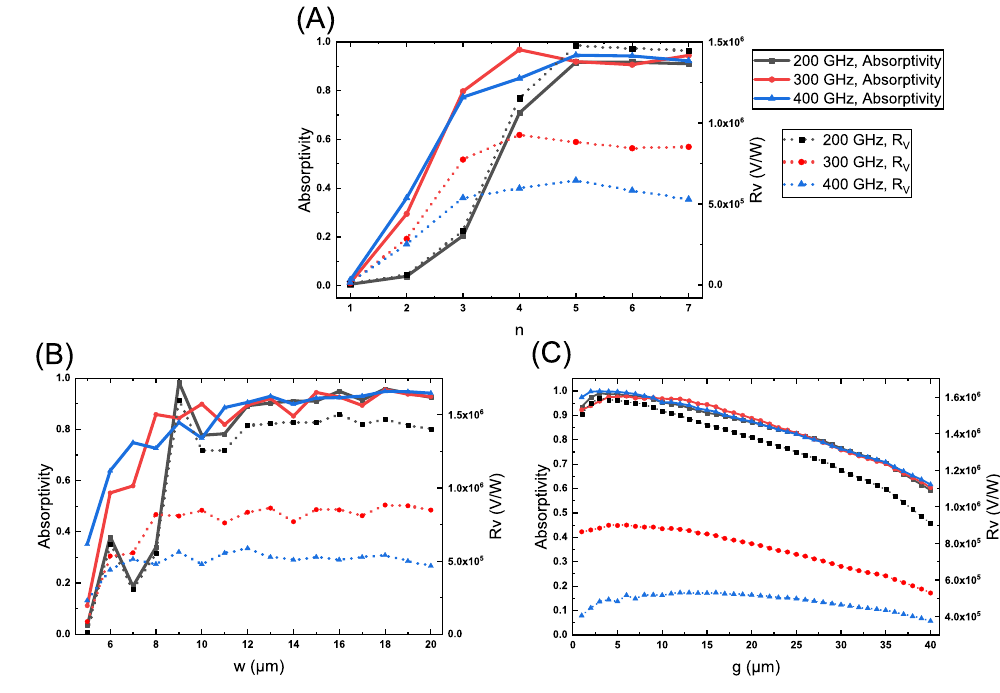
Figure 10. Absorptivity and responsivity versus ( A ) n, ( B ) w, and ( C )